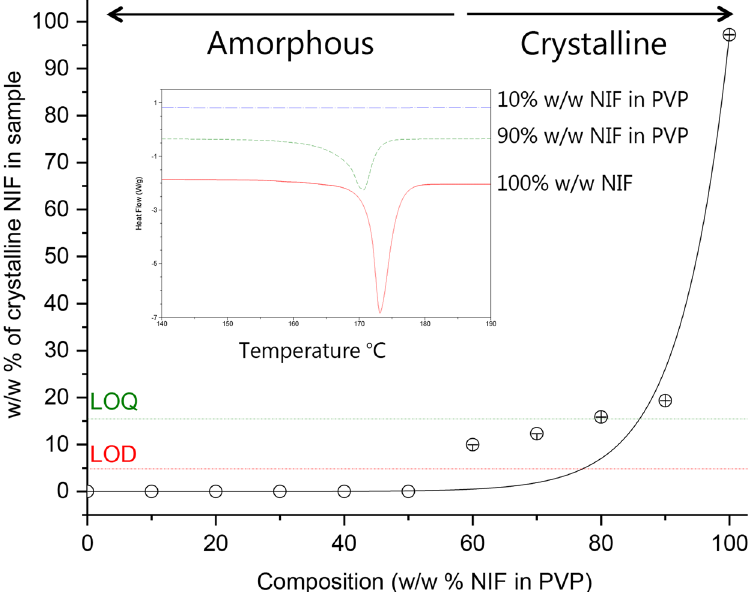
Figure 3. Crystallinity phase diagram for freeze-dried samples at first heat. The w/w % of crystalline NIF in samples was calculated using a calibration graph based on physical mixes of NIF in PVP. Error bars represent the standard error of n = 3. Thermogram showing first-heat of freeze-dried formulations 100, 90 and 10% w/w NIF in PVP. DSC cycle include a ramp from − 10 to 190 °C at a rate of 10